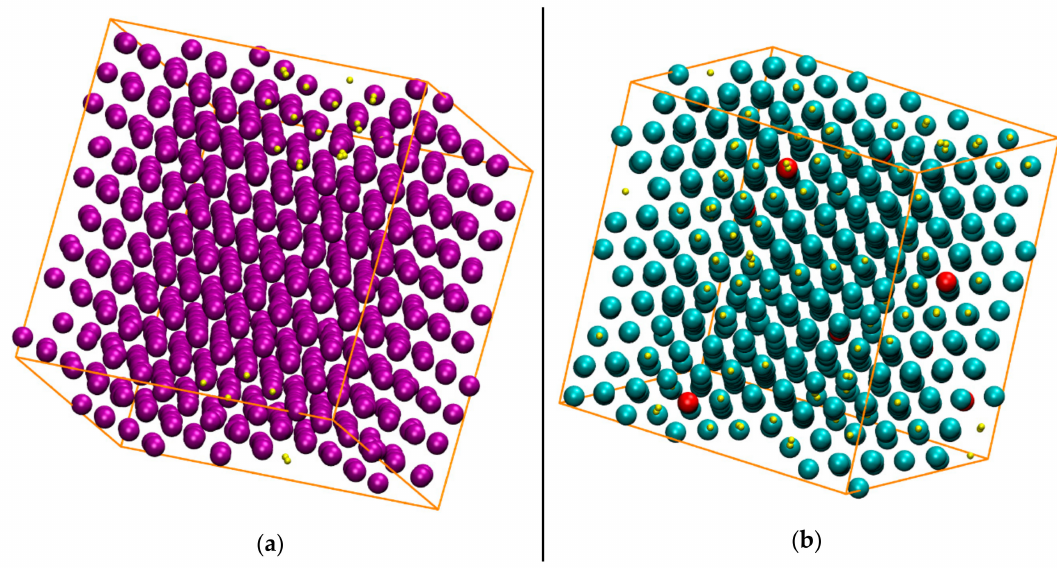
Figure 7. Snapshots at the end of NPT MC simulations on SW monomers. ( a ) ε = 2.1 and σ 2 = 1.6; ( b ) ε = 2.7 and σ = 1.3. Spheres are color-coded according to the X -crystal similarity ( ε X < ε thres = 0.245) as 2 identified by the value of the CCE norm. Blue, red, green, purple and cyan colors correspond to HCP, FCC, FIV, HEX and BCC crystals, respectively. Crystal sites are shown with reduced diameter in a 3:5 scale. Amorphous (or ”none of the above”) sites are shown in yellow color and reduced (1:5) diameter for visualization purposes. Image created with the VMD software. Each figure panel is also available as stand-alone image in 3-D, interactive format in the Supplementary